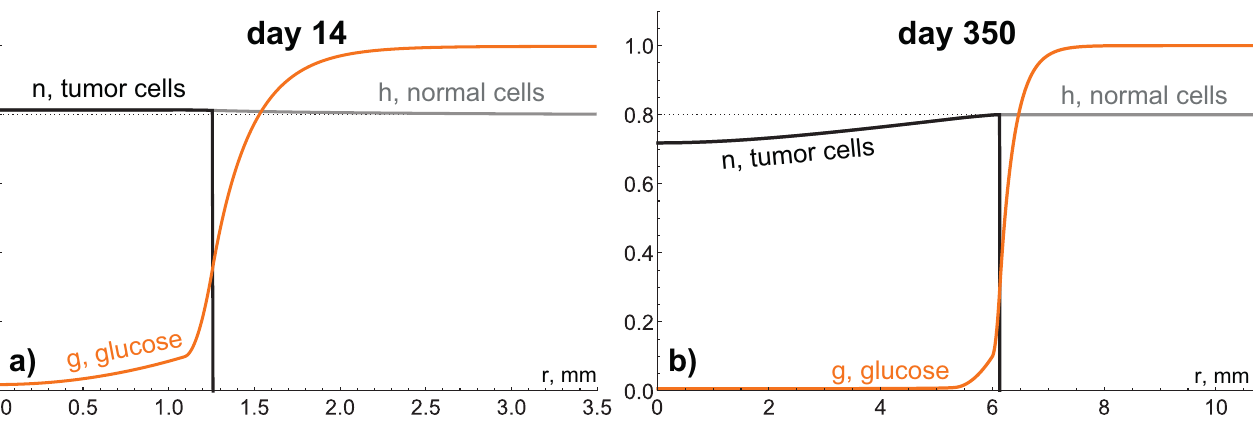
Figure 7. Distributions of the variables of the tumor growth model, governed by the system of Equation (6), produced by numerical simulations under tissue hydraulic conductivity K / µ = 0.3 and nutrient supply level P = 16 on the ( a ) 14th and ( b ) 350th days of tumor growth. Dotted lines denote the value of initial fraction of cells c 0